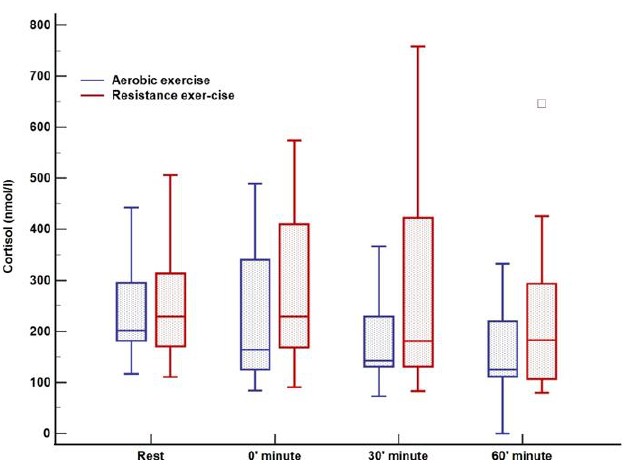
Figure 3. Lactate response to aerobic versus resistance training. The box-and-whisker plot displays the following: the median value (solid line within the box); the interquartile range (2 ends of the box); either the 5th or 95th percentile values or the smallest and largest observations (2 lines with caps extending from the box, the so-called whiskers); and any extreme outliers.